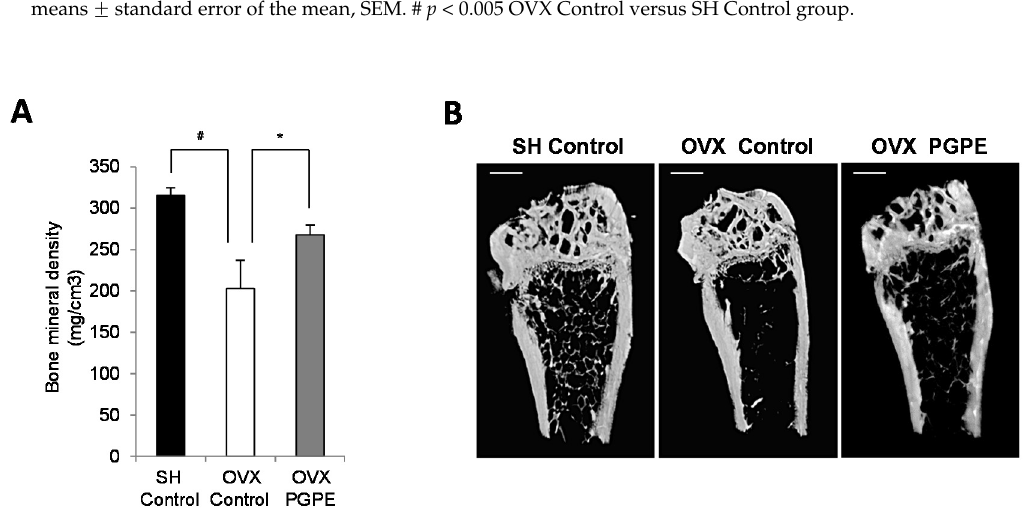
Figure 4. Effect of ovariectomy and pomegranate peel extract consumption for 30 days on bone parameters in mice. ( A ) Bone mineral density analysis of left femur by X-ray radiation micro-CT. Mice were sham-operated, SH or ovariectomized, OVX and fed standard diet AIN-93 (Control) or standard diet enriched with 2g/kg of pomegranate peel extract, PGPE representing a dose of 10 mg polyphenols/kg body weight/day (ellagic acid equivalent) for 30 days. Each group contained 10 mice. Results are presented as means ± standard error of the mean, SEM. # p < 0.005 OVX Control versus SH Control group. * p < 0.05 OVX PGPE versus OVX Control. ( B ) Representative microCT images of the distal left femur for each group: SH Control, OVX Control and OVX PGPE. Scale bars, 1 mm.